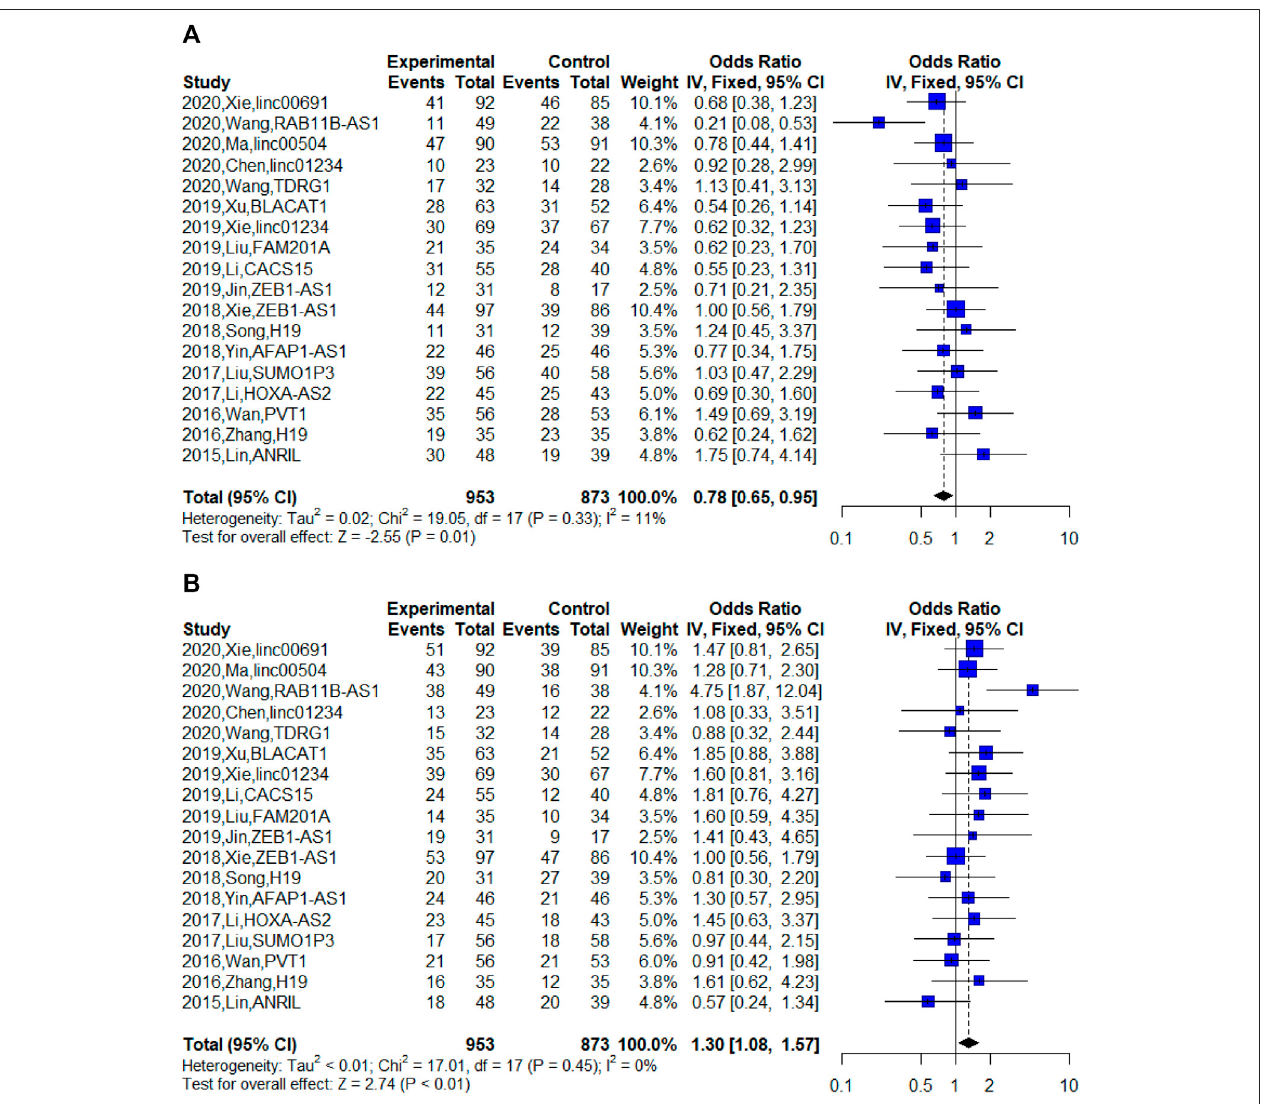
FIGURE 2 | Forest plots of the associations between the expression of long noncding RNAs (lncRNAs) and clinical features of non-small-cell lung cancer (NSCLC) [There were six clinical features that were signi fi cantly associated with the upregulated lncRNAs in NSCLC, (A) the histological type of lung squamous cell carcinoma (LSCC); (B) thehistologicaltypeoflungadenocarcinoma(LAD); (C) the Ⅰ / Ⅱ TNMstages; (D) the Ⅲ / Ⅳ TNMstages; (E) negativelymphnodemetastasis; (F) positivelymph node metastasis; (G) highormoderate differentiationgrade; (H) poordifferentiation grade; (I) negativedistantmetastasis; (J) positivedistantmetastasis; (K) tumor size no larger than 3 cm; and (L) tumor size larger than 3